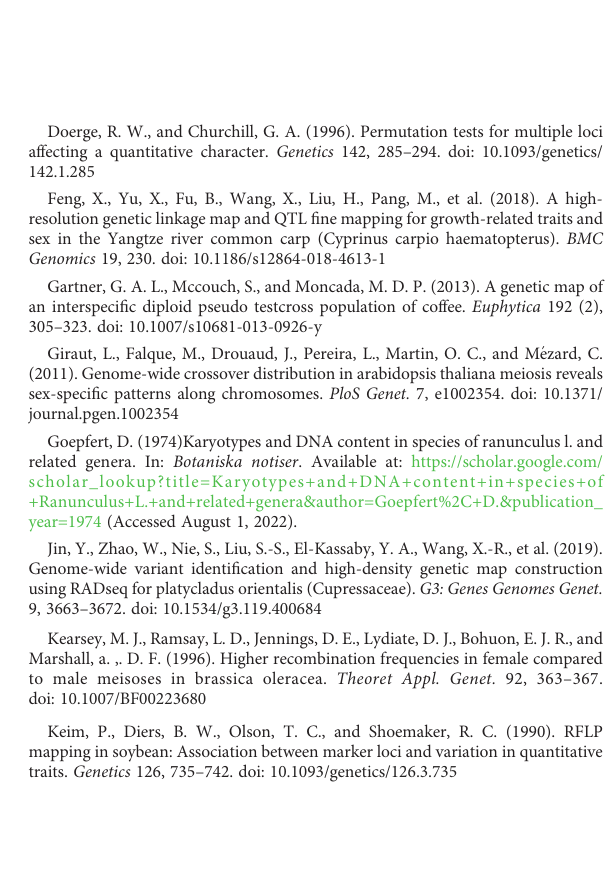
SUPPLEMENTARY FIGURE 1 Linkage Groups obtained after analysis, together with markers name. SUPPLEMENTARY FIGURE 2 Distribution of the investigated traits in the two